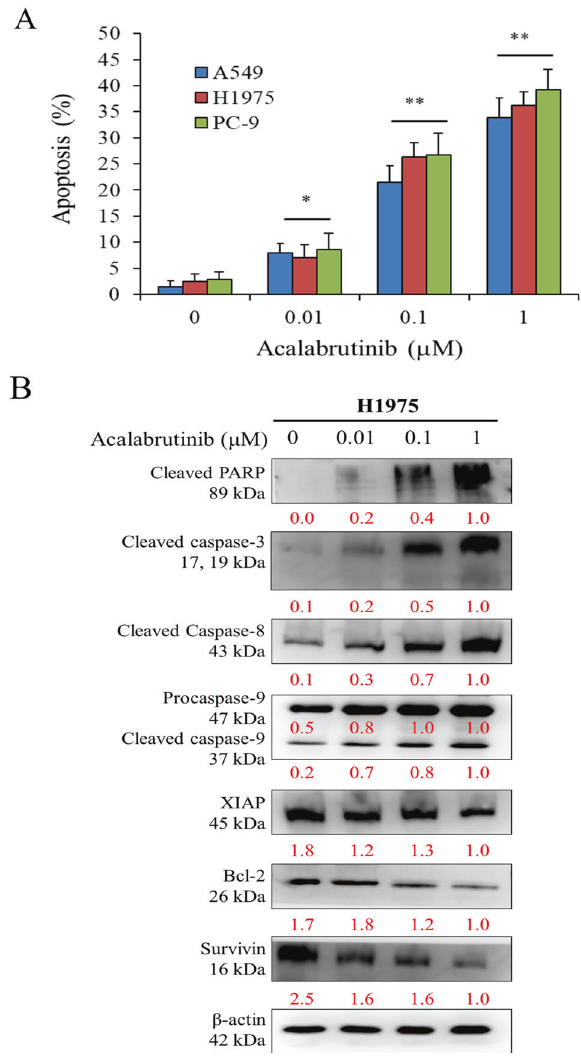
Fig. 5 BTK inhibitor Acalabrutinib induces apoptosis in A549 (EGFR wild type), H1975 (EGFR T790M), and PC-9 (mutant EGFR with 19 Del) cells. A Effects of Acalabrutinib on apoptosis induction after treatment of Acalabrutinib at the indicated concentrations for 48 h. Apoptosis was determined by the annexin-V/PI assay. Bars represent mean ± SD. * p < 0.05, ** p < 0.01. B Modulation of Acalab- rutinib on apoptotic proteins in Ge fi tinib-resistant H1975